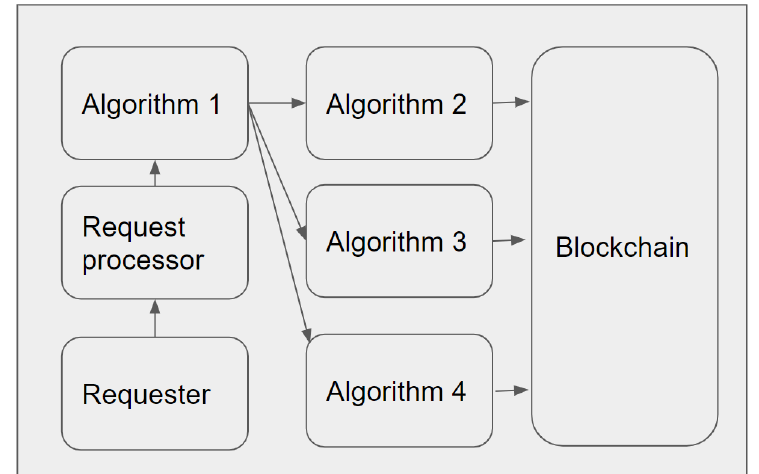
Figure 13. Computation logic of DIdM-EIoTD in a LIdM.